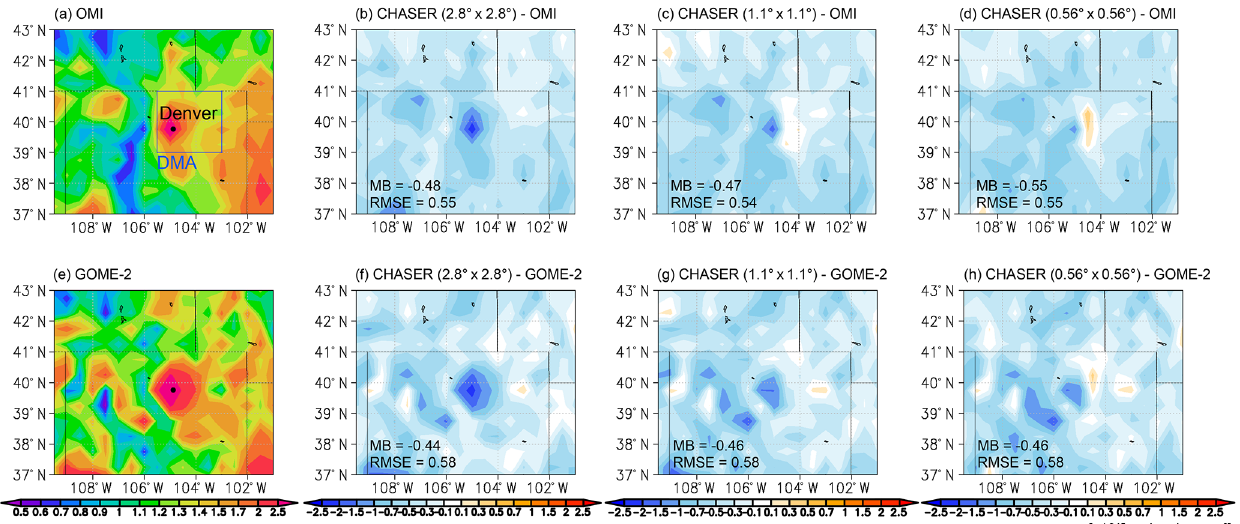
Figure 9. Regional distributions of tropospheric NO 2 column ( × 10 15 moleculescm − 2 ) from satellite retrievals (first column; a , e ) and differences between the model simulation at 2.8 ◦ (second column; b , f ), 1.1 ◦ (third column; c , g ), and 0.56 ◦ (fourth column; d , h ) resolutions and satellite retrievals from OMI (upper row; a–d ) and GOME-2 (lower row; e–h ) over Colorado state during July–August 2014. The observed and simulated fields are mapped onto a 0.5 ◦ bin grid. The DMA area is shown by the blue square in (a) .